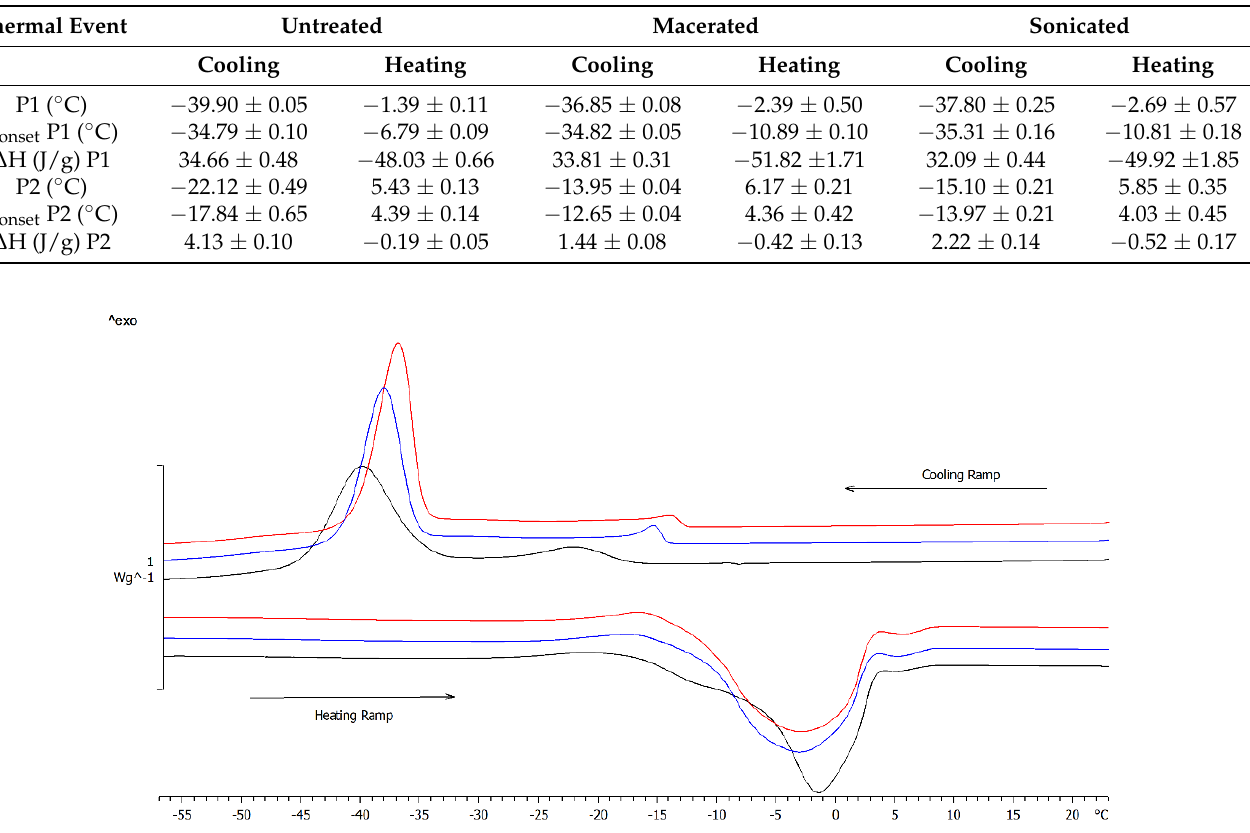
Figure 3. DSC profiles of refined olive oil as raw material (black line) and after maceration for 40 min (red line) or UAE for 10 min using a 7 mm probe (blue line).